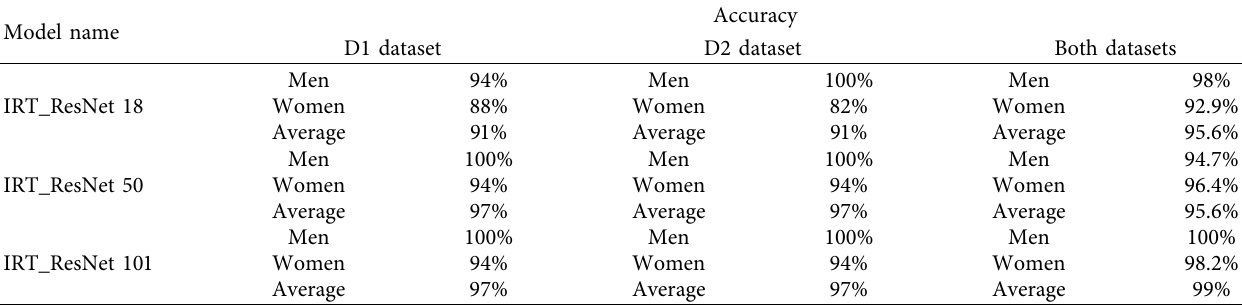
Table 2: The IRT_ResNet models’ accuracy comparison.